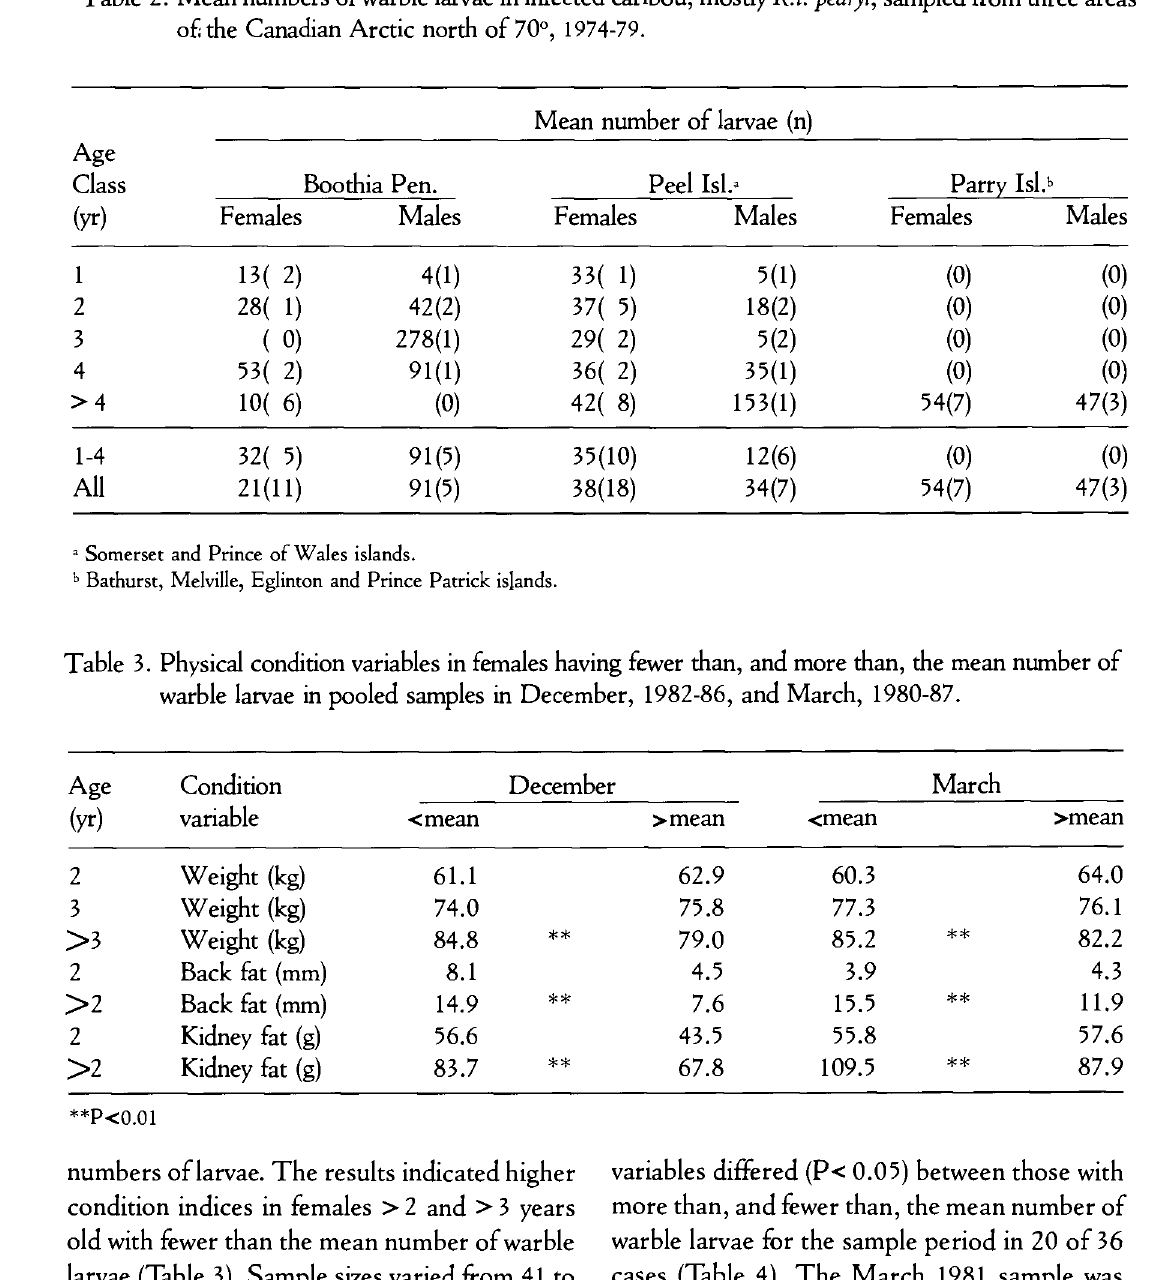
Table 3. Physical condition variables in females having fewer than, and more than, the mean number of warble larvae in pooled samples in December, 1982-86, and March,